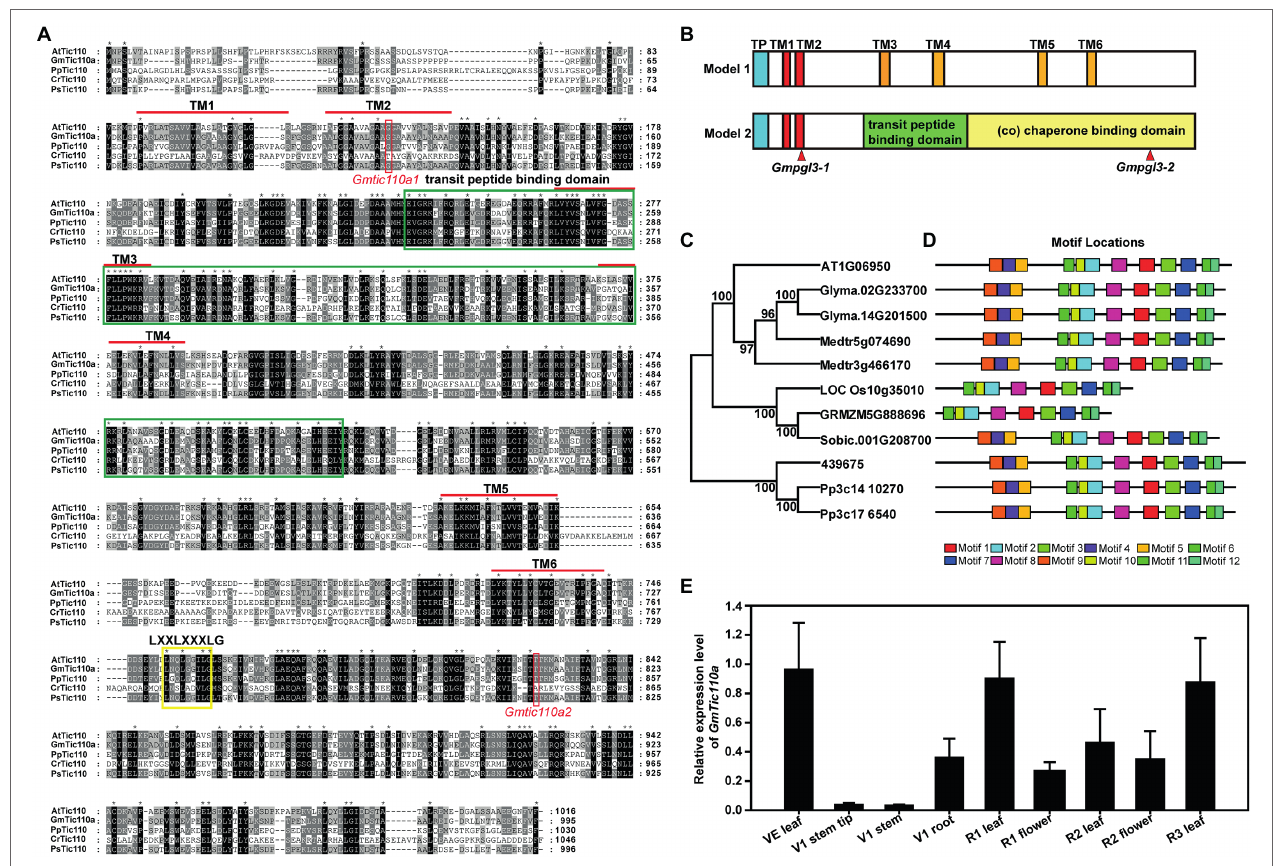
FIGURE 3 | (A) Multiple sequence alignments of the Tic110 protein in Arabidopsis thaliana (At), Glycine max (Gm), Physcomitrella patens (Pp), Chlamydomonas reinhardtii (Cr), and Pisum sativum (Ps). The dark region represents identical amino acids, and the grey region represents similar amino acids. (B) Schematic diagram representations of the two structural models of the Tic110 protein. In terms of the locations of the proposed TM domains, the red boxes represent TM1 and TM2, the orange boxes represent TM3 to TM6, the blue boxes represent transit peptides (TPs), the green box represents TP binding, and the yellow box represents a co-domain. (C) Phylogenetic trees based on the multiple sequence alignments of the Tic110 proteins. Bootstrap values from 1,000 replicates are indicated at each node. (D) Conserved motifs of Tic110 proteins in G. max , A. thaliana , Medicago sativa , Oryza sativa , Zea mays , Sorghum bicolor , Selaginella tamariscina , and P. patens were identified using the MEME search tool. Different motifs (1–12) are represented by boxes with different colors. (E) Tissue-specific expression profiles were determined via